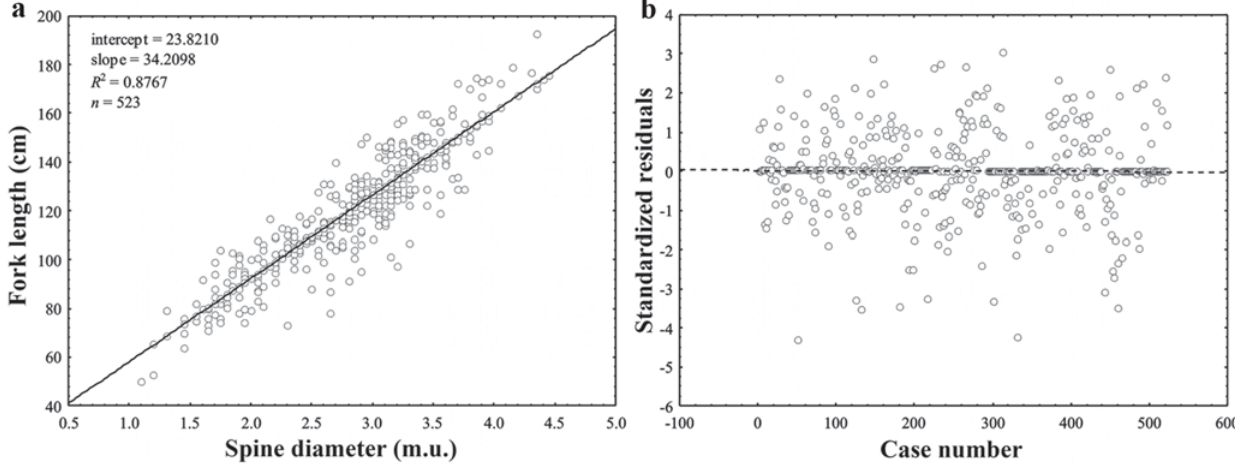
Fig. 3. Linear fit ( a ) and plot of residuals ( b ) of the relationship between spine diameter and fork length for bigeye tuna, T. obesus , off northeastern Brazil.